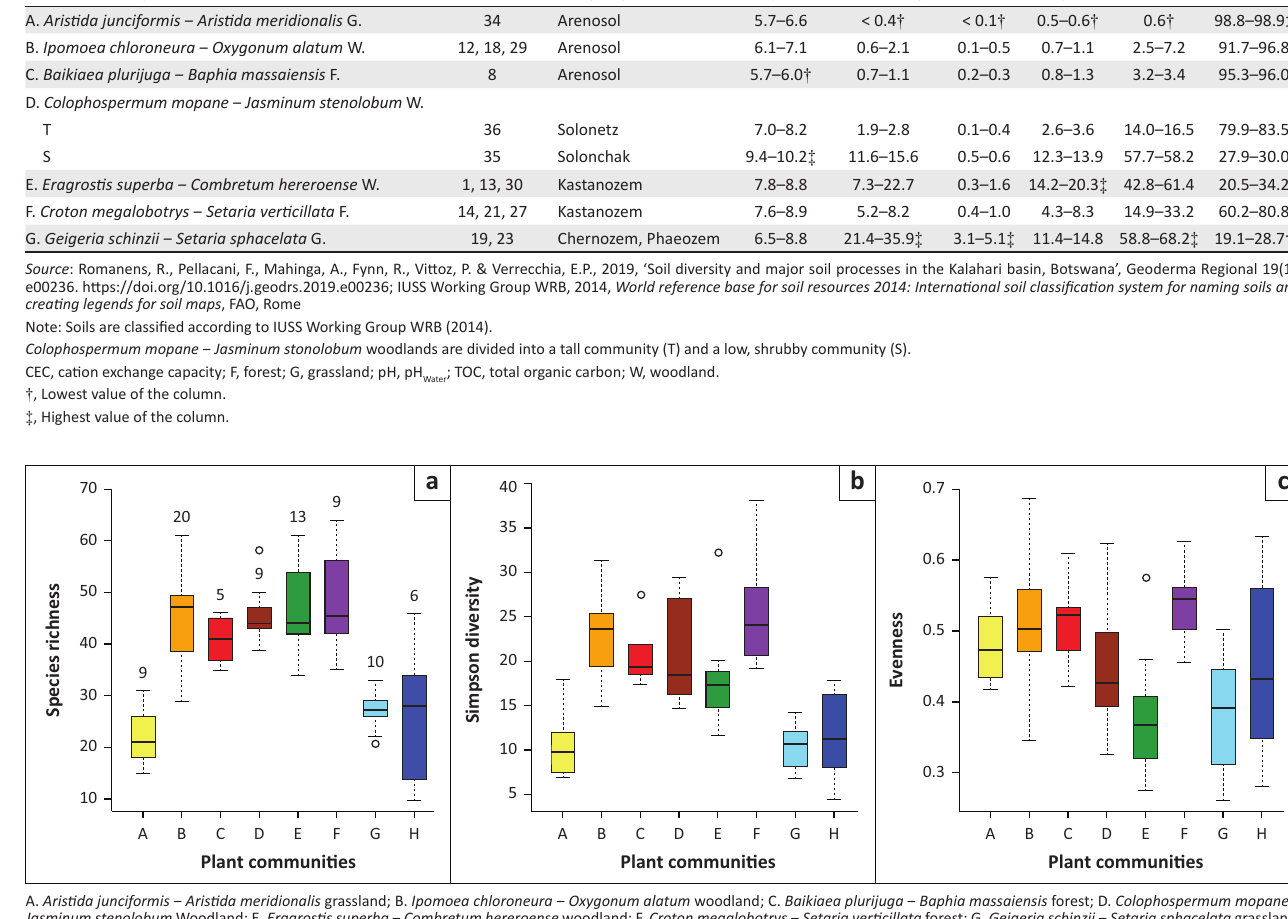
TABLE 2: Ranges of selected physicochemical parameters measured in soil samples between 0–15 cm and 15–30 cm of profiles described by Romanens et al. (2019), and grouped by plant communities. Plant community